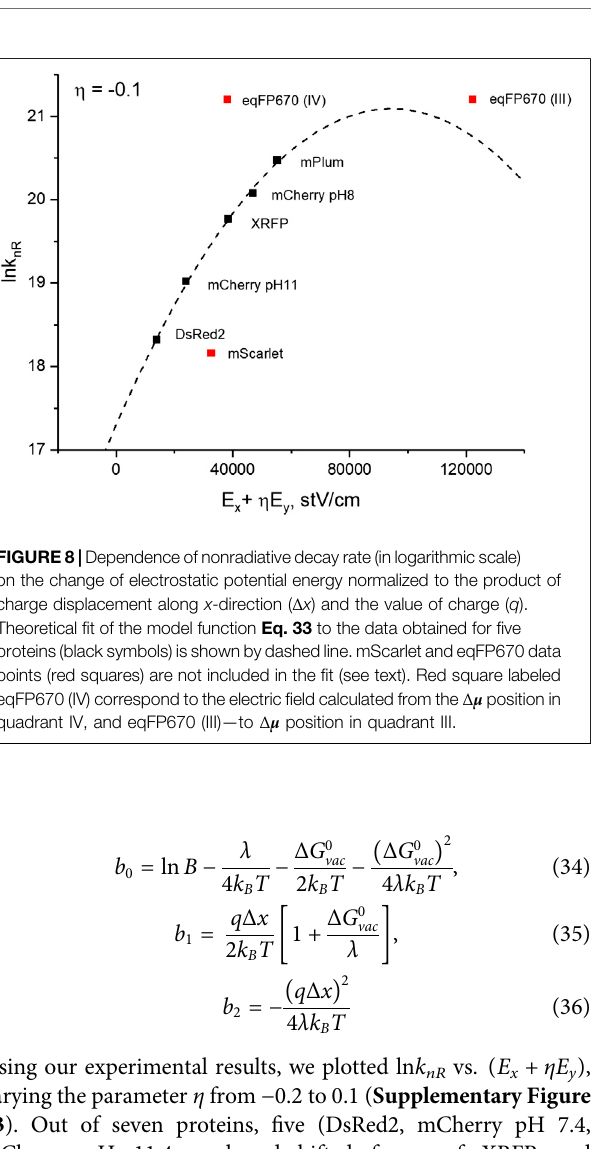
( Supplementary Figure S4 ). The fi nal plot of ln k nR vs ( E x + η E y ) corresponding to η (cid:2) − 0.1 is shown in Figure 8 .